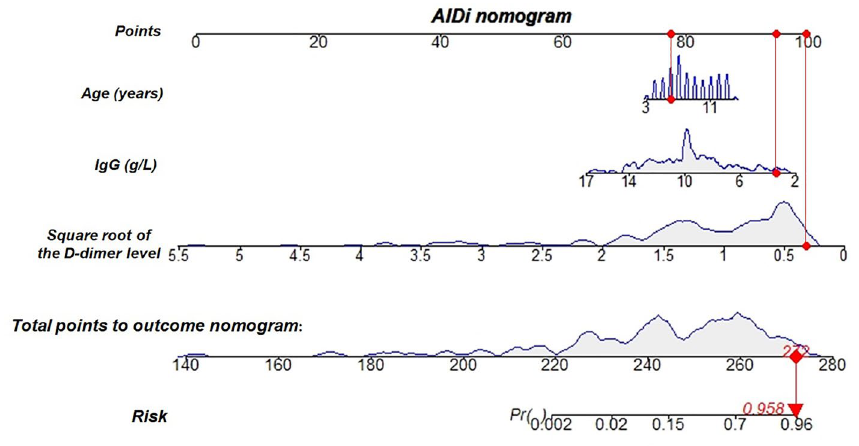
Figure 3. AIDi nomogram for predicting the risk of IgA vasculitis nephritis.